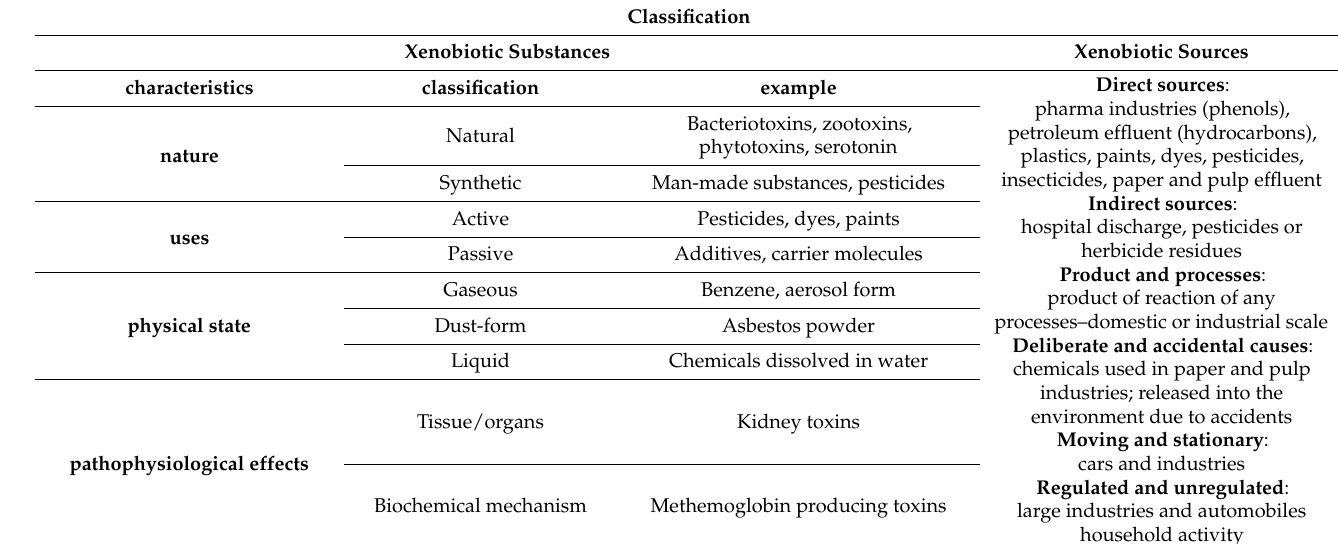
Table 1. Substances and sources of xenobiotics (modified by